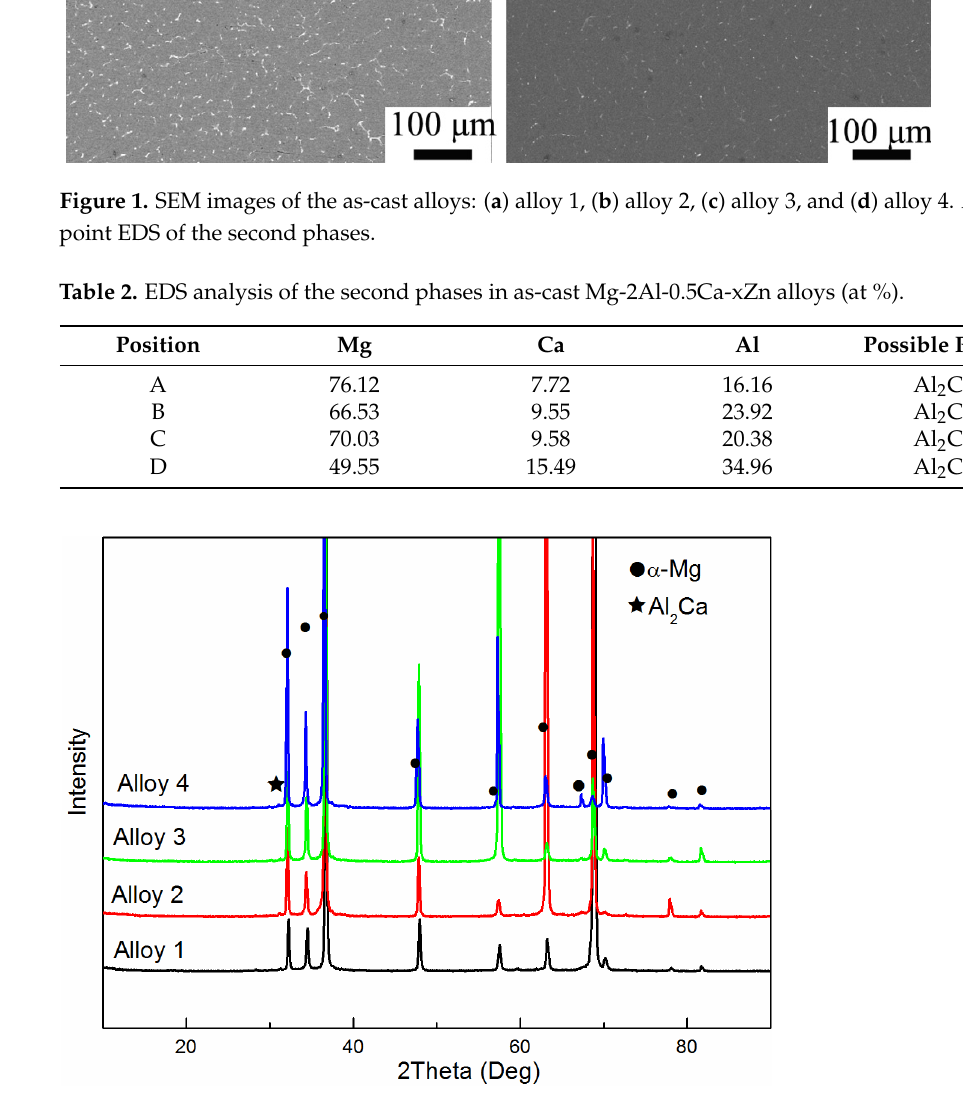
Figure 2. X-ray diffraction spectra of the as-cast alloys.